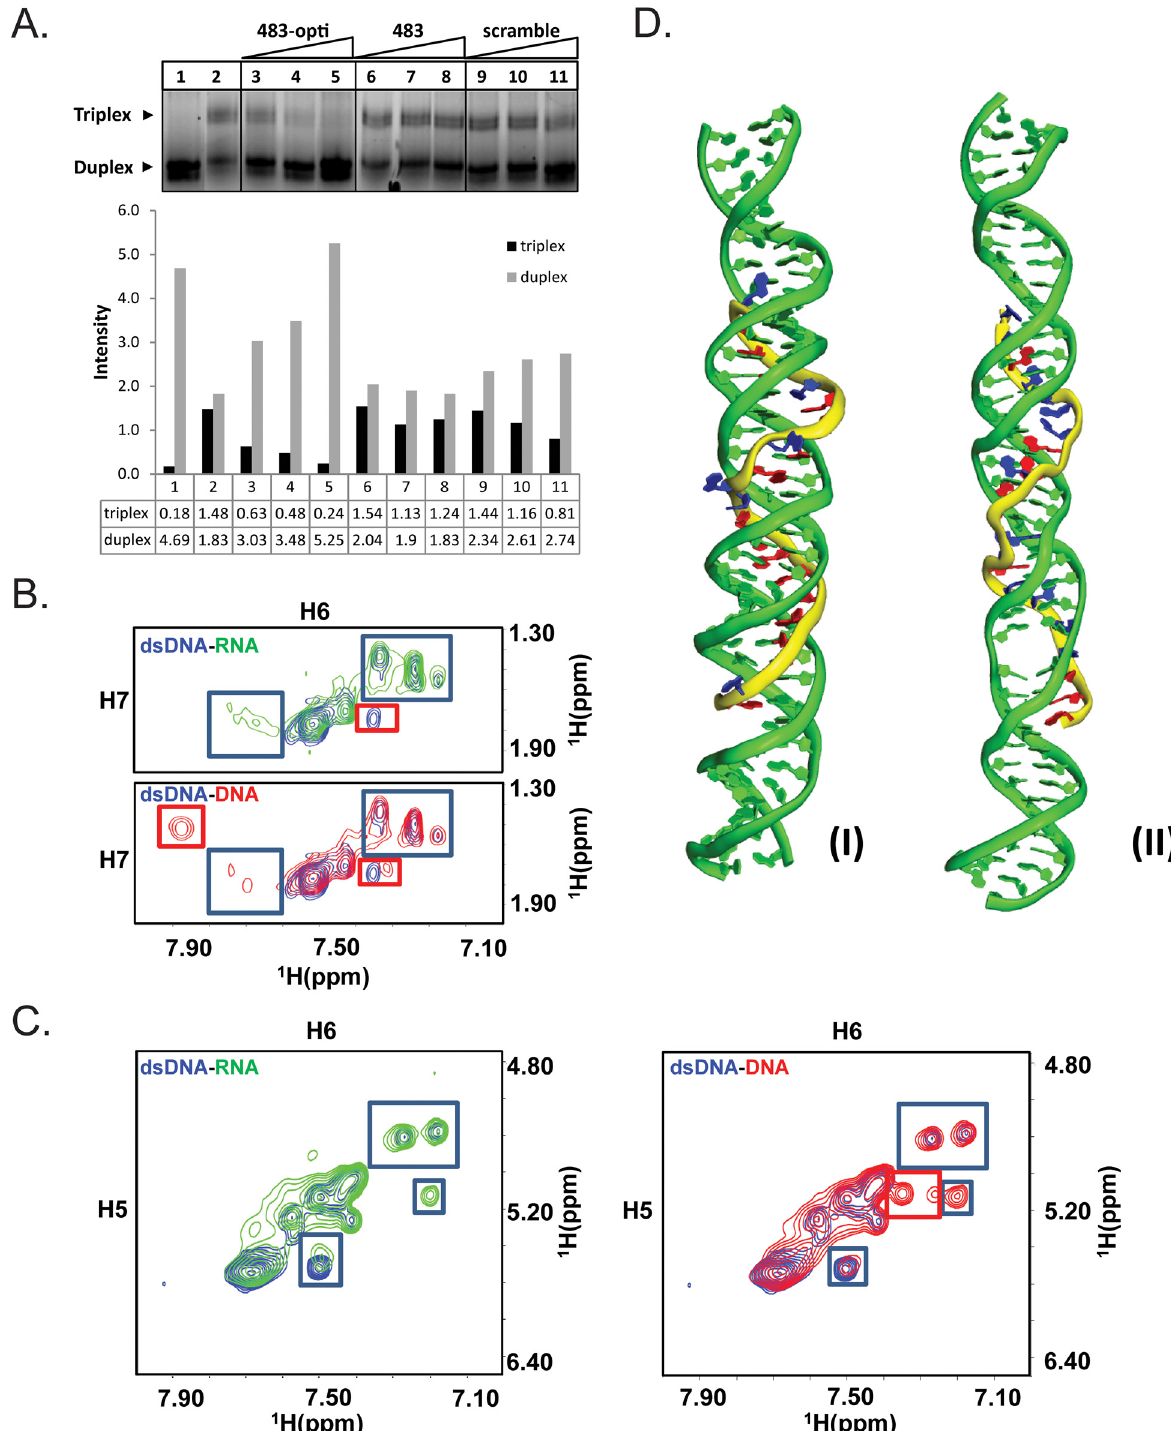
Fig 4. Detection of DNA-DNA and RNA-DNA triplexes by EMSA and NMR, and molecular modeling of miRNA-duplex DNA triplex. (A) EMSA; 5 ’ ROX-labeled hairpin duplex DNA (0.1 μ M) was incubated for 3-hrs at 22°C in the presence (lanes 2 – 11) or absence (lane 1) of 2.5 μ M 483-opti DNA oligo, and increasing concentration (30, 60, 150 μ M) of Hoogsteen bond-optimized hsa-miR-483-5p (483-opti, lanes 3 – 5), hsa-miR-483-5 (483, lanes 6 – 8), or a scrambled RNA oligo (Scramble, lanes 9 – 11). Duplexes and triplexes were resolved on a 20% non-denaturing acrylamide gel, and the ROX-signal visualized. Triplex of 483-opti DNA oligo and duplex DNA is readily detected (lane 2). The 483-opti RNA oligo competes with 483-opti DNA oligo for binding to